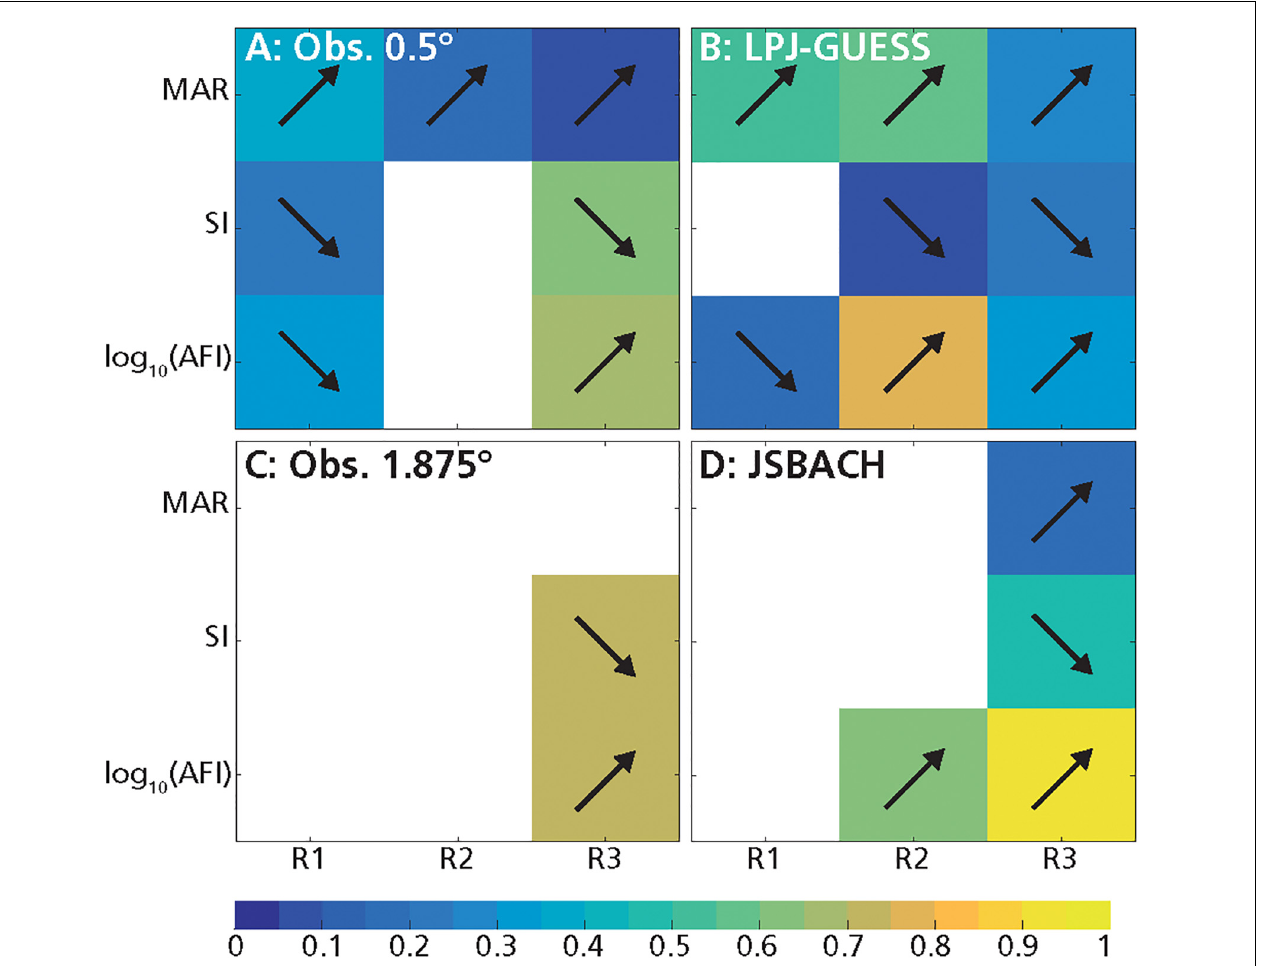
FIGURE 6 | Deviance explained (R 2 ; color scale) of the GLMs of tree cover with the three abiotic predictors at low mean annual rainfall (MAR) (R1: MAR ≤ 590 mm year − 1 ), intermediate MAR (R2: 590 mm year − 1 < MAR < 1200 mm year − 1 ) and high MAR (R3: MAR ≥ 1200 mm year − 1 ): (A) obs. 0.5 ◦ , (B) LPJ-GUESS, (C) obs. 1.875 ◦ , (D) JSBACH. Arrows indicate the tendencies of the relationships between tree cover and abiotic factors (increasing or decreasing). White grid cells indicate that there were no significant